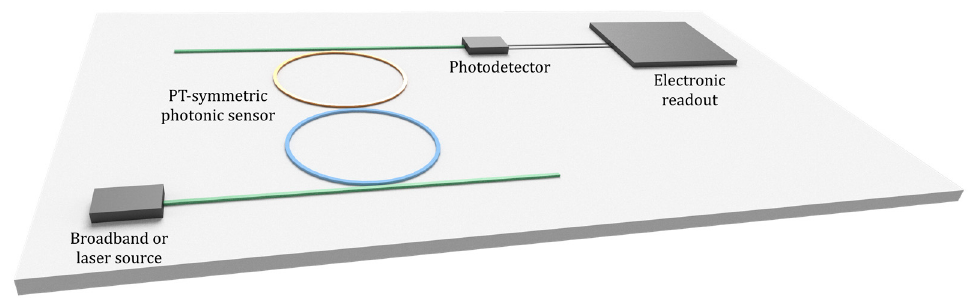
Figure 9. Chip implementation of a PT-symmetric photonic sensor with an integrated source (broadband or laser), a photodetector, and the electronic readout.